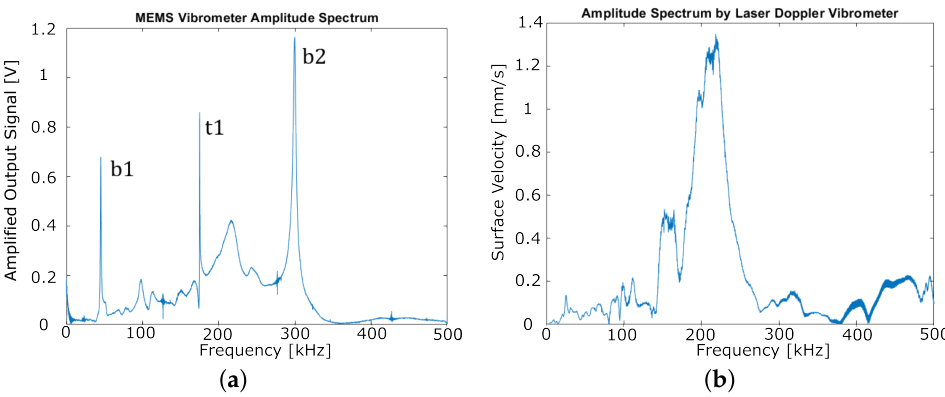
Figure 10. ( a ) Frequency response of the MEMS vibrometer chip as obtained by the setup shown in Figure 6. Bending (b1, b2) and torsional modes (t1) are indicated. ( b ) Velocity amplitude as obtained by the LDV